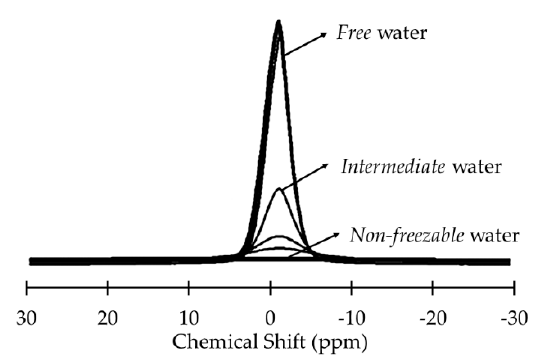
Figure 4. 2 H-NMR spectra of water on a surface at different temperatures. The narrower peaks correspond to temperatures above 0 °C, while broad lines correspond to temperatures below 0 °C. Modified from [32]. Copyright 2010 Taylor & Francis.